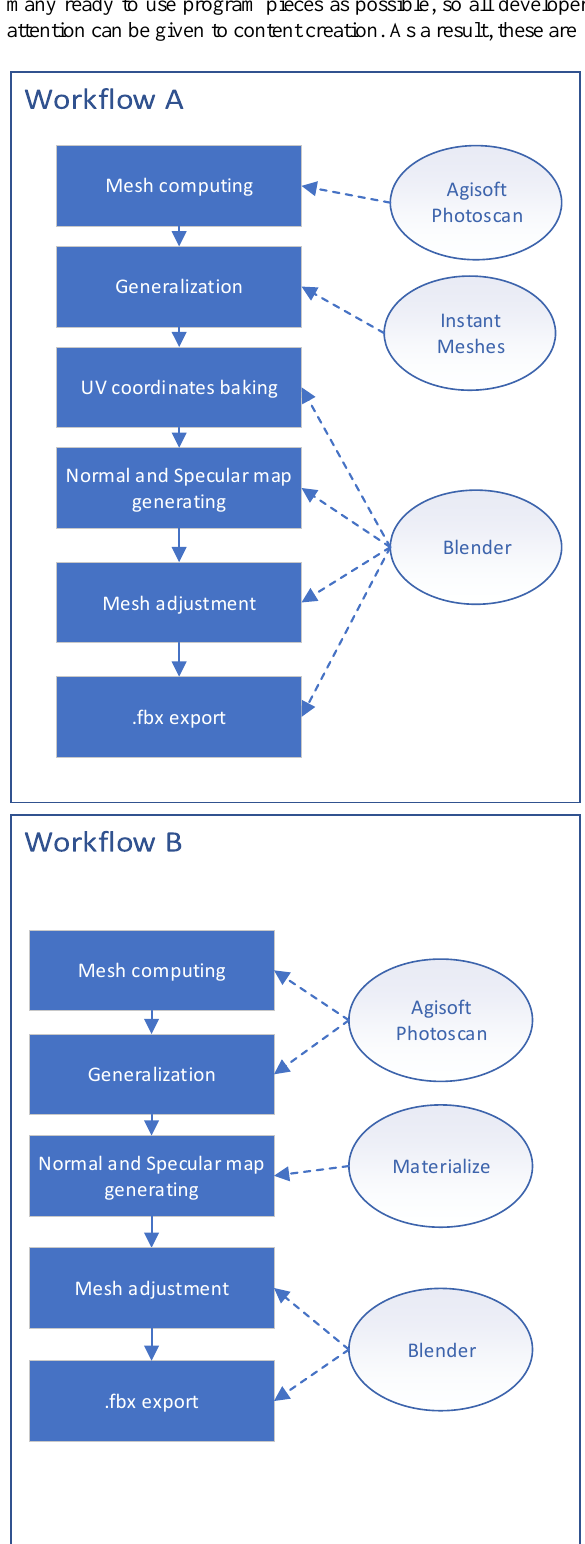
Figure 4. Comparison of data preparation